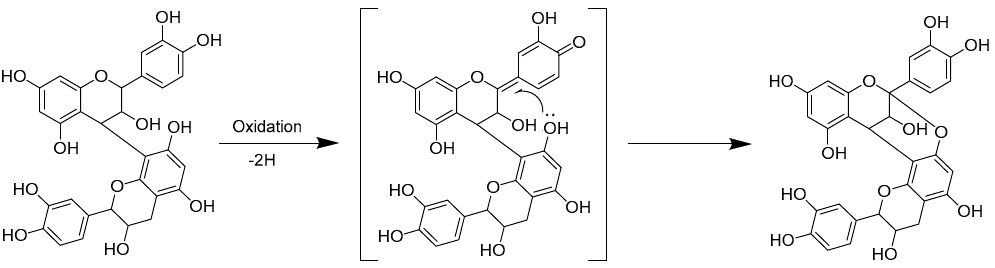
Figure 7. The suggested mechanism for the conversion of B-type procyanidin dimer to A-type dimer according to [15,37]. Molecules 2021 , 26 , x